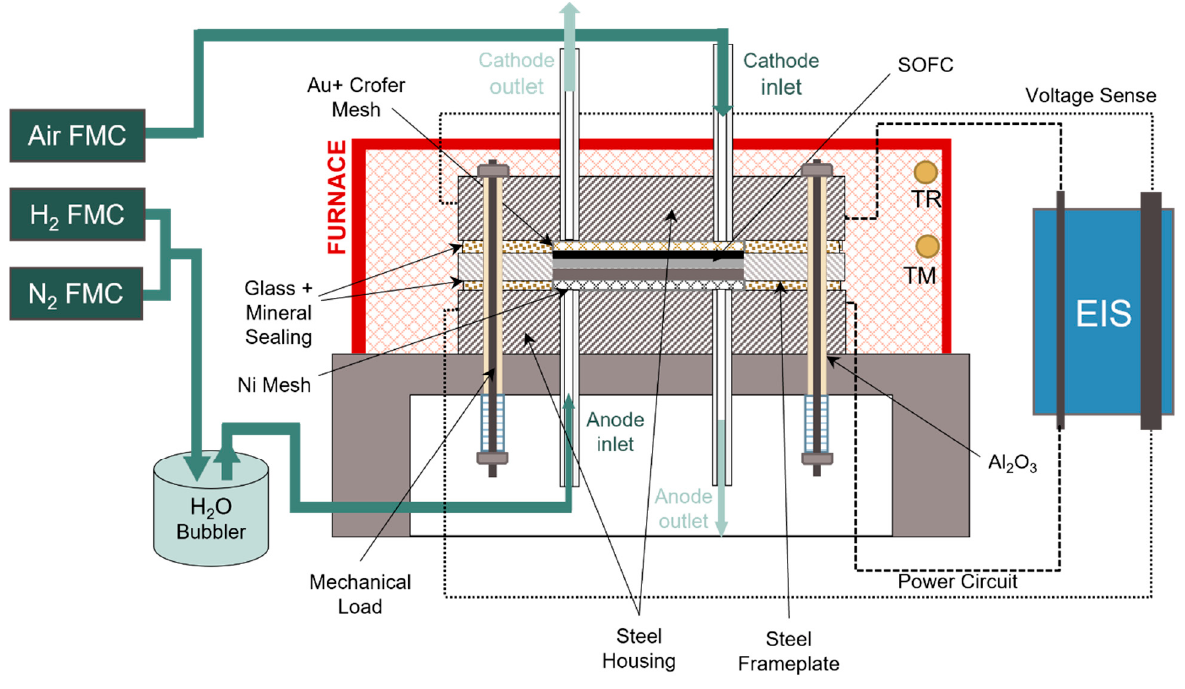
Figure 3. SOFC test rig scheme: mechanical and electrical connection, measurement hardware.